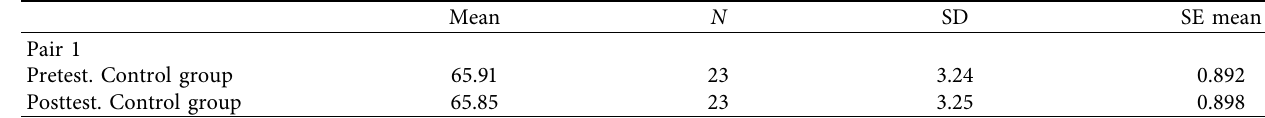
Table 8: Descriptive results (control group) (CG).